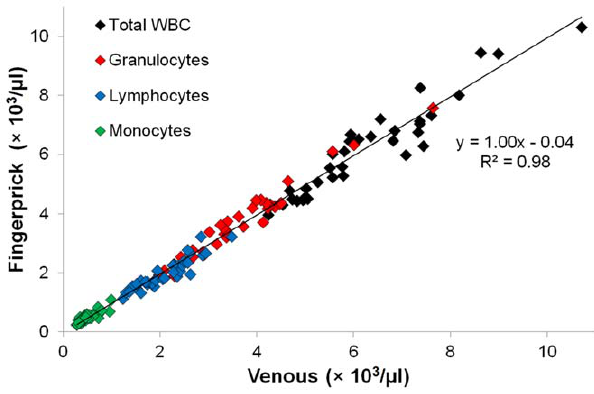
Figure 2. Concordance between venous and fingerprick samples on standard hematology analyzer. Concordance be- tween venous and fingerprick blood samples for total and 3-part differential leukocyte concentrations measured using a Sysmex XE-2100 hematology analyzer (n=36). Solid line shows linear least-squares regression of all leukocyte populations.